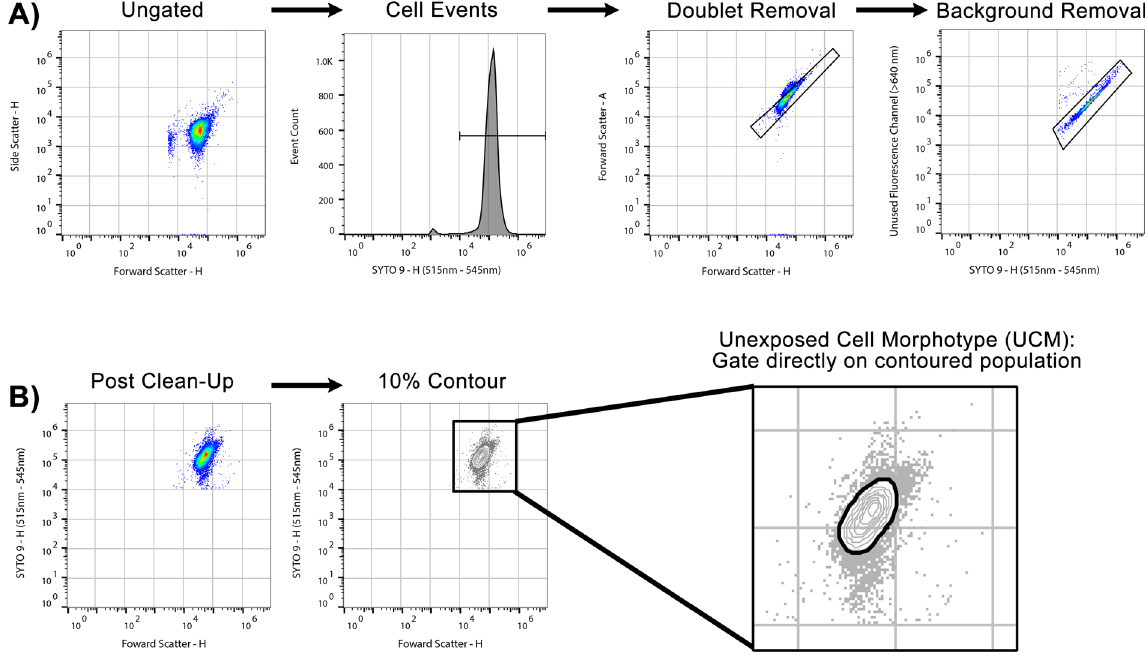
Figure 3. Susceptibility to meropenem can be identified by AFC by observing a susceptibility-associated signature. ( A ) Exposure of the K. pneumoniae susceptible type strain (ATCC 700603) increased forward scatter, SYTO ® 9 fluorescence, reduced overall event numbers, and formed a new contouring focus at the isolate’s MIC (0.25 mg/L). At 32 × MIC, a total of four contouring foci were observed, with an overall shift towards low forward scatter, low fluorescent debris. The progression of these features, when observed in combination, constitutes the susceptibility-associated signature. Colouring on biaxial plots indicates separate contouring foci. Fluorescence micrographs (acquired at 60x magnification) show reduced overall cell numbers and increase aberrant cell morphotypes as meropenem concentration increases. ( B ) Exposure of highly resistant clinical K. pneumoniae strain K8 to meropenem shows an absence of susceptibility-associated signature across clinically relevant meropenem concentrations by flow cytometer bi-axial plot, and an absence of aberrant cell morphotypes by fluorescence